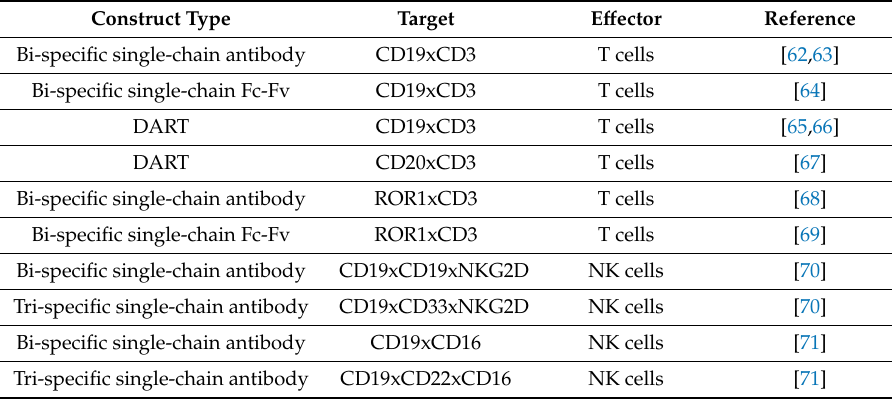
Table 3. Overview of bi- and tri-specific killer engagers tested in vitro in